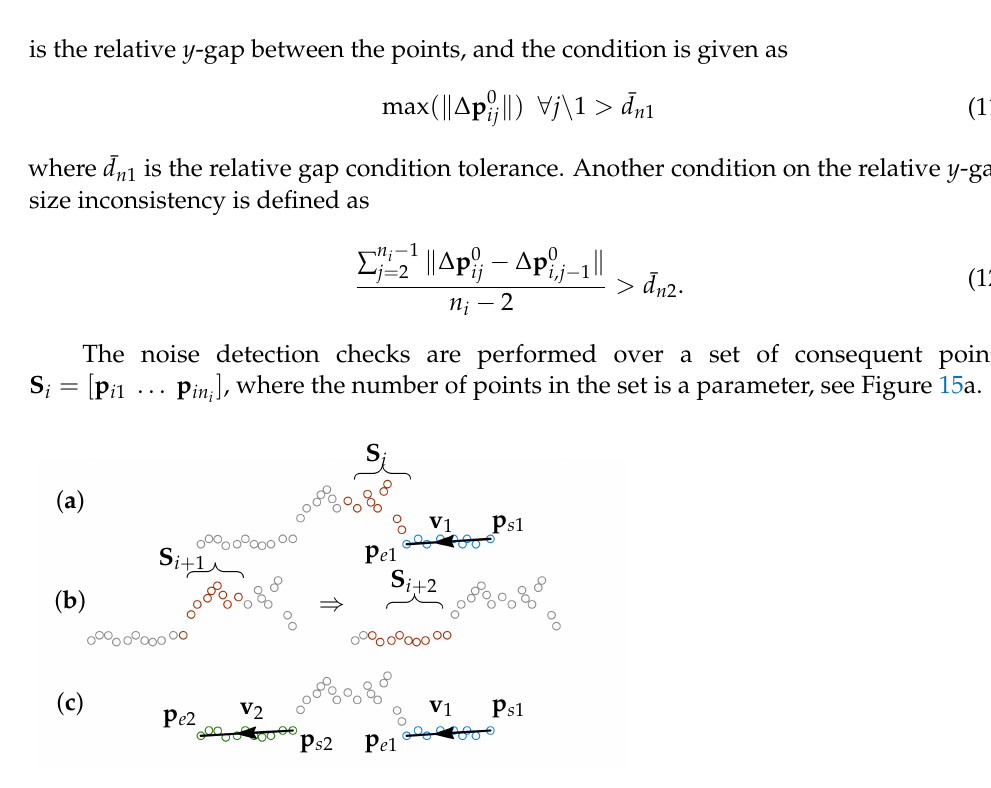
Figure 15. Schematic representation of the noise detection procedure. When segment 1 is found, the algorithm detects noise in the set of the following points S j ( a ), then the following point sets S j + 1 and S j + 2 are checked for noise ( b ), segment 2 is defined once a noise free set is found ( c ).